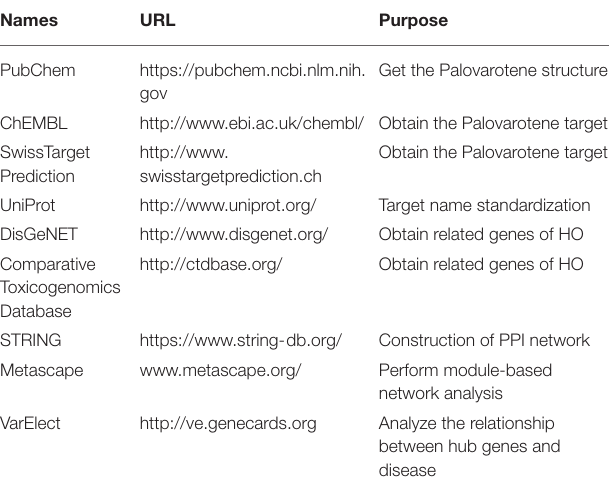
TABLE 1 | The database and related analysis platform used in this